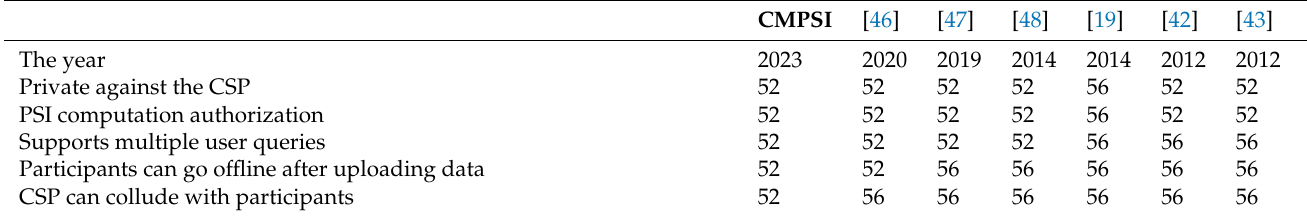
Table 1. Comparison with existing schemes.